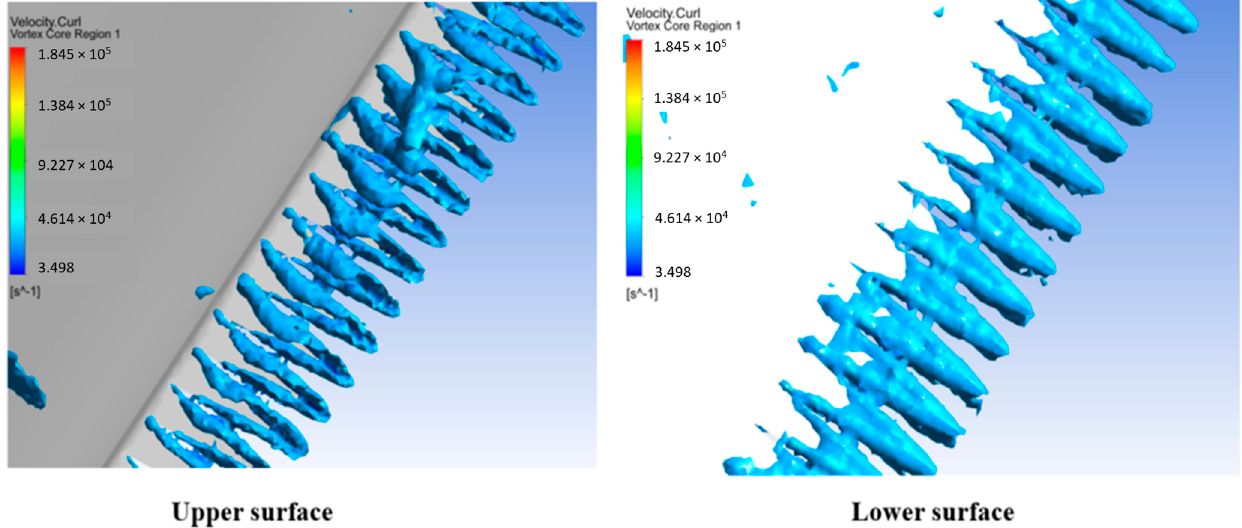
Figure 12. Vorticity core region with level 0.15 at V = 10 m/s .